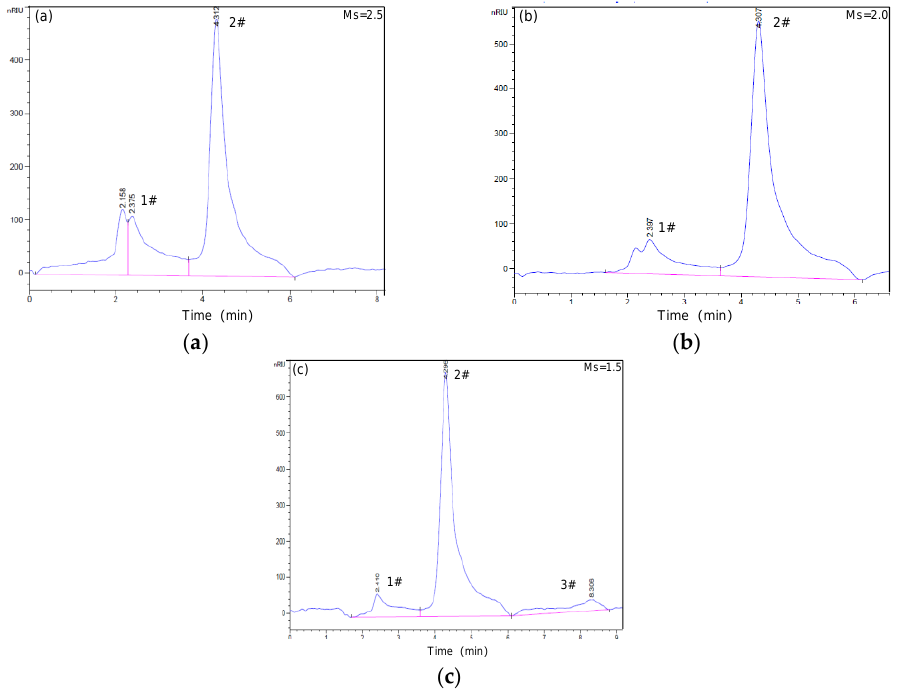
Figure 5. ( a ) Morphology and ( b ) DLS (Dynamic light scattering) spectra of alkaline activators. Figure 6 shows the molecular weight distribution of the alkaline activators determined by the GPC measurements. Three peaks can be seen in the curves, including a primary peak at approximately 4.29–4.31 min (2#), a second peak at 2.19–2.41 min (1#) and a third peak at 8.31 min (3#), which were assigned to the three types of molecular structures in the waterglass. With decreasing Ms, the characteristic peak strength and area of the second and third peaks show a significant increase. However, the trend for the primary peak is opposite. It well known that the larger molecular weight of samples could not through the small pore structure of gel column to reduce outflow time, which resulting in the smaller retention time of molecular [31]. Therefore, the molecule weight of samples obviously decreases for Ms < 1.5.